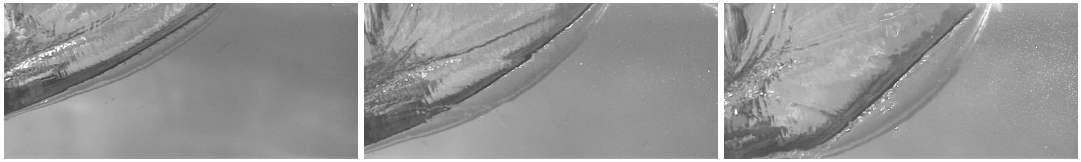
Figure 14. Maximum dimension of the wavefront during the water entry of a wedge ( V ) ( β = 20 ◦ ) entering the water at 4.3, 6, and 6.7